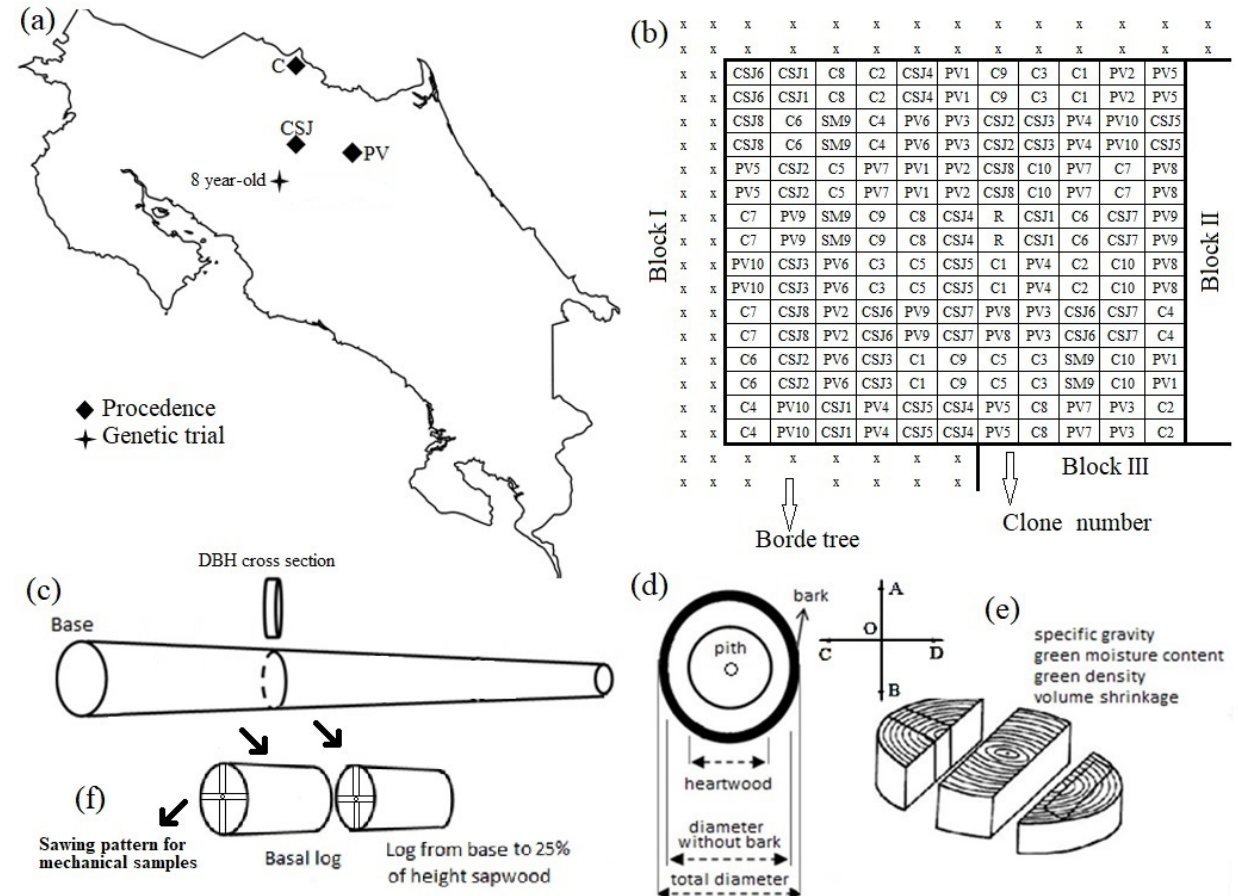
Figure 1. ( a ) Geographic location of the provenance/progeny trial of 8-year-old Dipteryx panamensis , northern region of Costa Rica: Coope San Juan (CSJ), Puerto Viejo (PV), and Crucitas (C) prove- nances. ( b ) Distribution of families within the block. ( c ) Sampled cross-section extraction from stem. ( d ) Parameters measured in cross-section and ( e ) cut pattern of cross-section for physical properties determination. ( f ) Sawing pattern for mechanical properties.